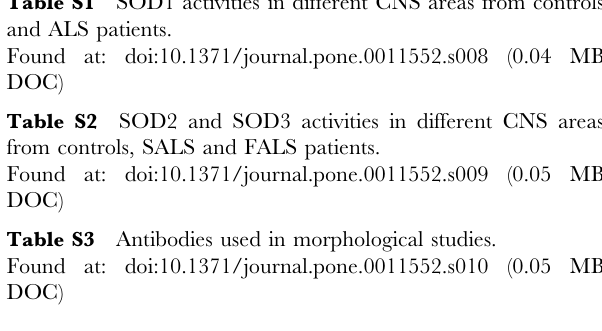
SOD1 exposes hydrophobic internal structures, and the preparation used for the ELISA and immunocapture experi- ments (Figure 2, Figure S2 and S3), was found to bind quantitatively to the column. Figure S6 Comparison of reactivities of antipeptide antibodies versus SOD1 in human and murine spinal cords. Equal amounts of extracts from ventral horns from a SALS and a FALS case and spinal cords from a SOD1 knockout mouse, a C57Bl6 control mouse and a wild-type human SOD1 transgenic mouse were examined by western blots using the 4–Ra-ab, 57– Ra-ab, 131–Ra-ab and 131–Ch-ab antibodies. In none of the cases was any reaction seen with proteins in the knockout homogenate, demonstrating the specificity of the antibodies. The 131–153 sequence is equal in human and mouse SOD1 and similar reactions are found in the extracts from the ALS cases and the control mouse. The other two antibodies showed lower cross-reactivities with murine SOD1 as expected. Figure S7 Confocal micrographs of sections from ventral horns of SALS patients and neurological control patients, and analysis of SOD1 by western blot. The micrographs depict the findings of the three different chicken antibodies (24-37Ch-ab, 58-72Ch-ab, 131- 153Ch-ab, respectively; green fluorescence). In the SALS patients small granular inclusions were seen with all three antibodies. In the neurodegenerative and non-neurological control patients no inclusions were seen in motoneurons. Homogenates of tissue from the spinal cord ventral horns from one control patient, one SALS and one FALS patients were analyzed by western blots, using the 24-37Ch-ab, 57-72Ch-ab and 131-153Ch-ab anti-SOD1 peptide antibodies. Short, intermediate and long exposures are presented. Weak nonspecific bands at about 51, 41 and 32 kDa were seen with the 24-37Ch-ab anti-SOD1 antibody. Since they were not seen with the other antibodies they are probably not related to SOD1 and thus unspecific. The total intensities were estimated at approximately 3% of that of the SOD1 monomer. The scale bars are 18 m m. Table S1 SOD1 activities in different CNS areas from controls and ALS patients.